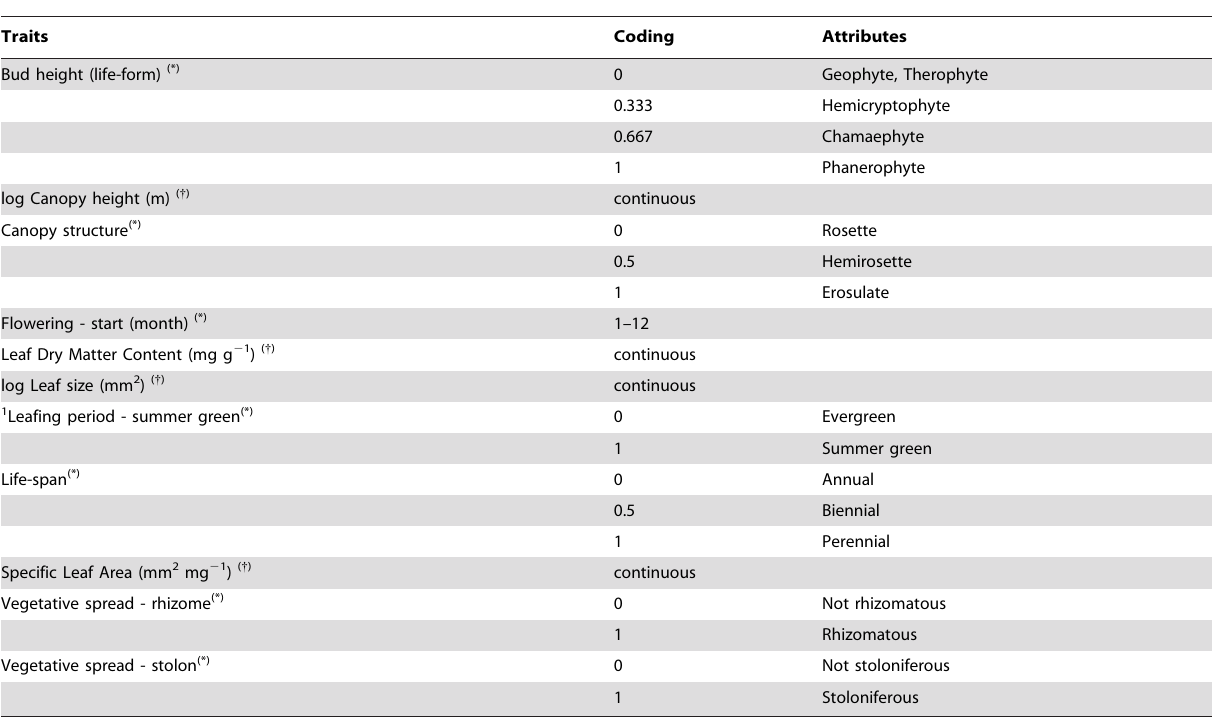
Table 1. Traits used in the analysis with source and coding information.